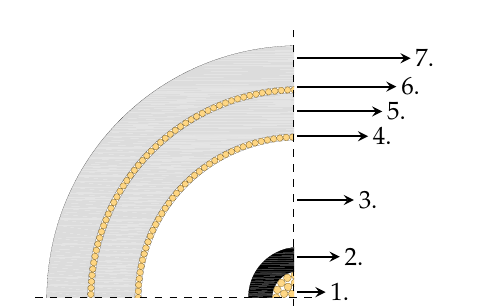
Figure 3. Power supply cable.